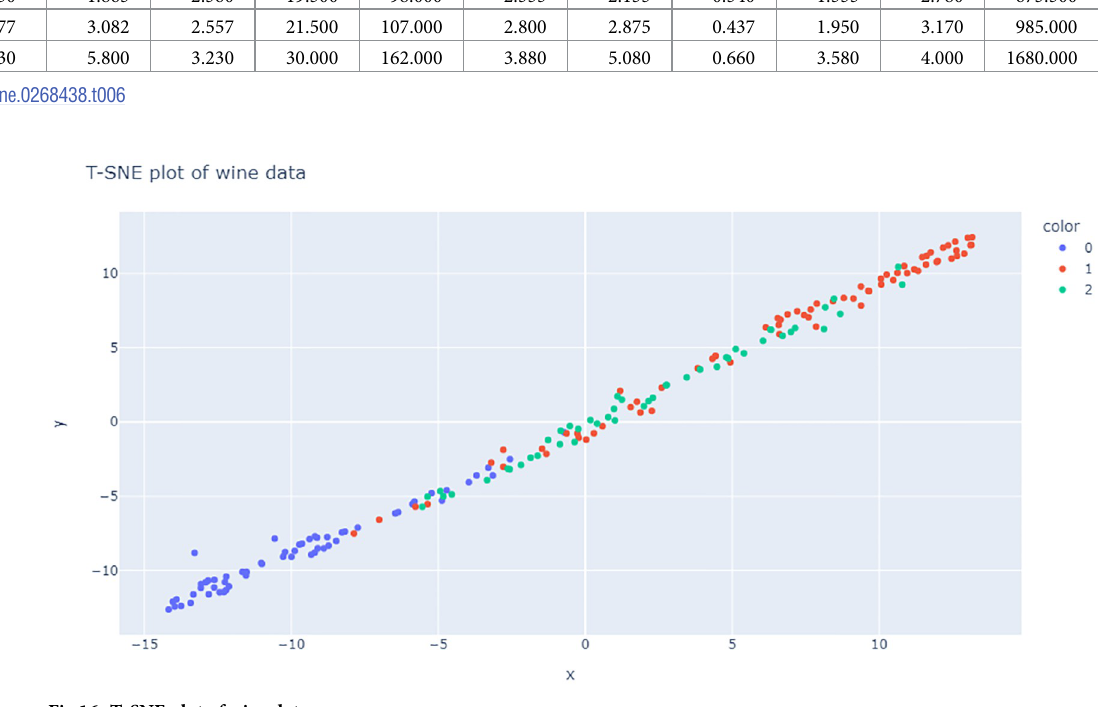
Fig 16. T-SNE plot of wine data.